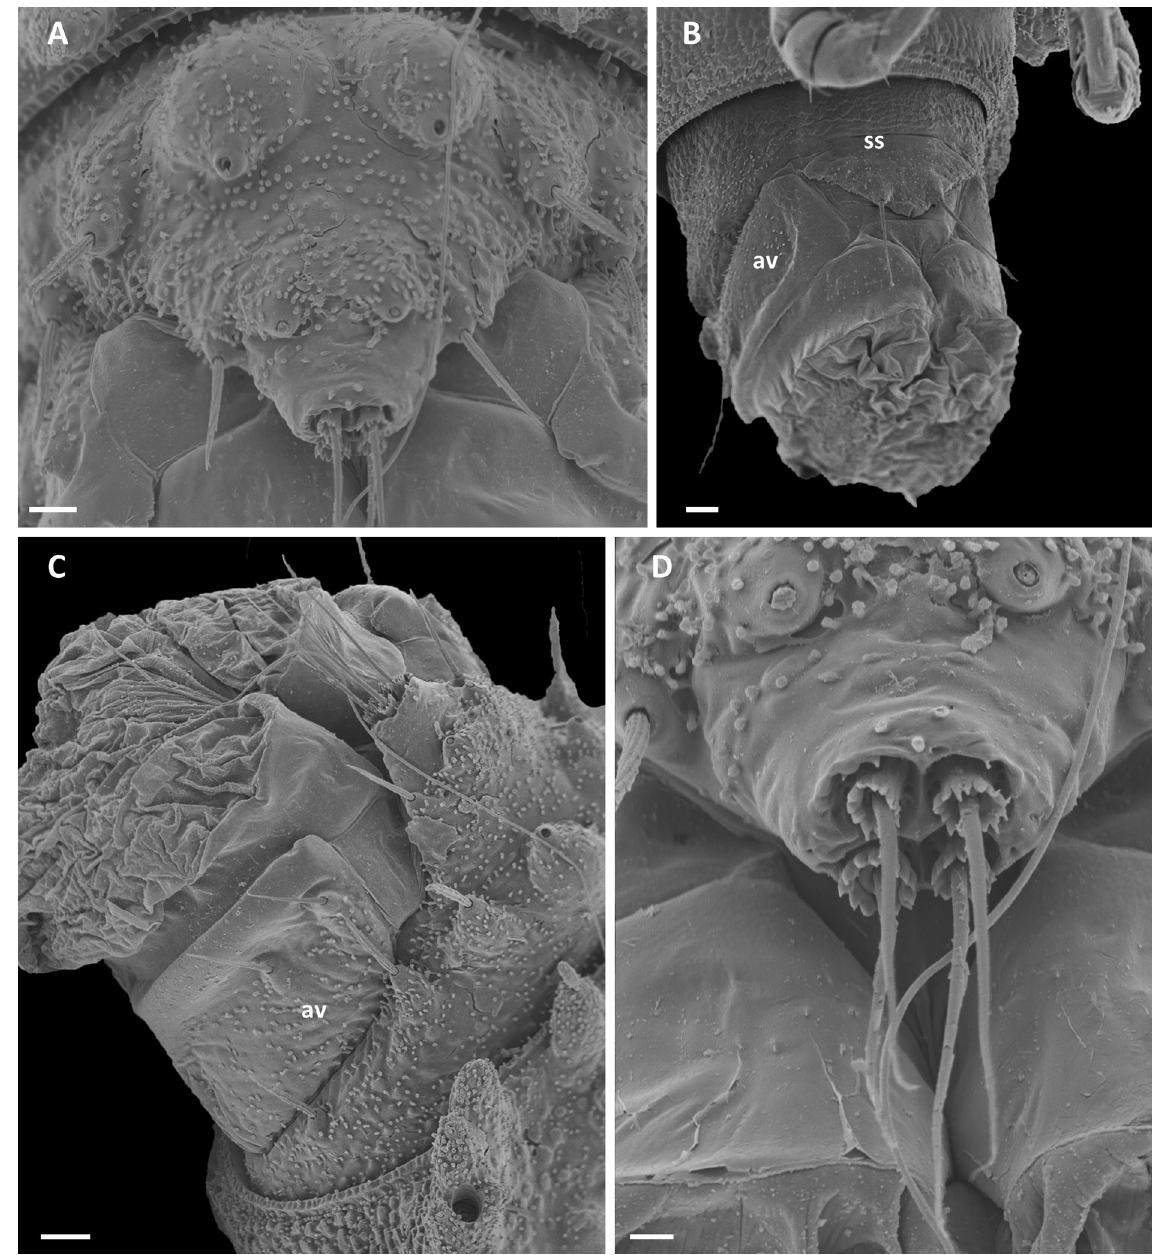
Fig. 4. Cryptocorypha geminiramus sp. nov., paratype (NHMD 621824), ♂, from Kidatu, telson. A . (Posterio)-dorsal view B . Ventral view. C . Oblique lateral view. D. Spinnerets. Abbreviations: av = anal valve; ss = subanal scale. Scale bars: A = 0.01 mm; B–C = 0.02 mm; D = 0.005